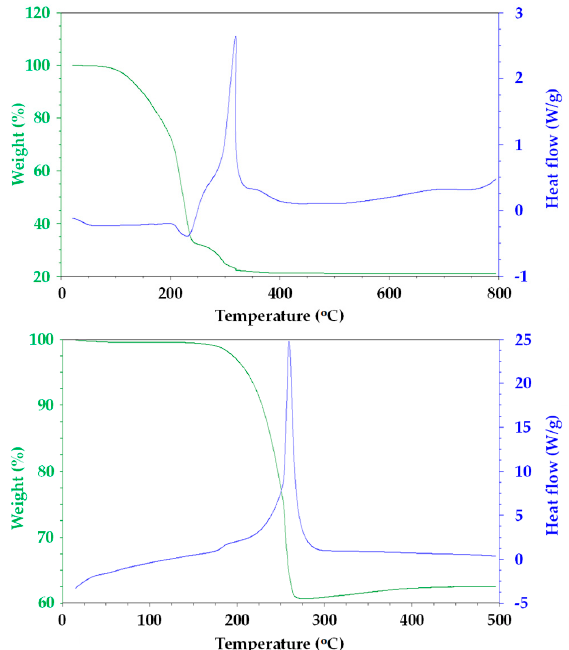
Figure 1. Thermal gravimetric and heat flow data from (top) CeO 2 and (bottom) MnO 2 pastes. Exotherm is up on the heat flow data.